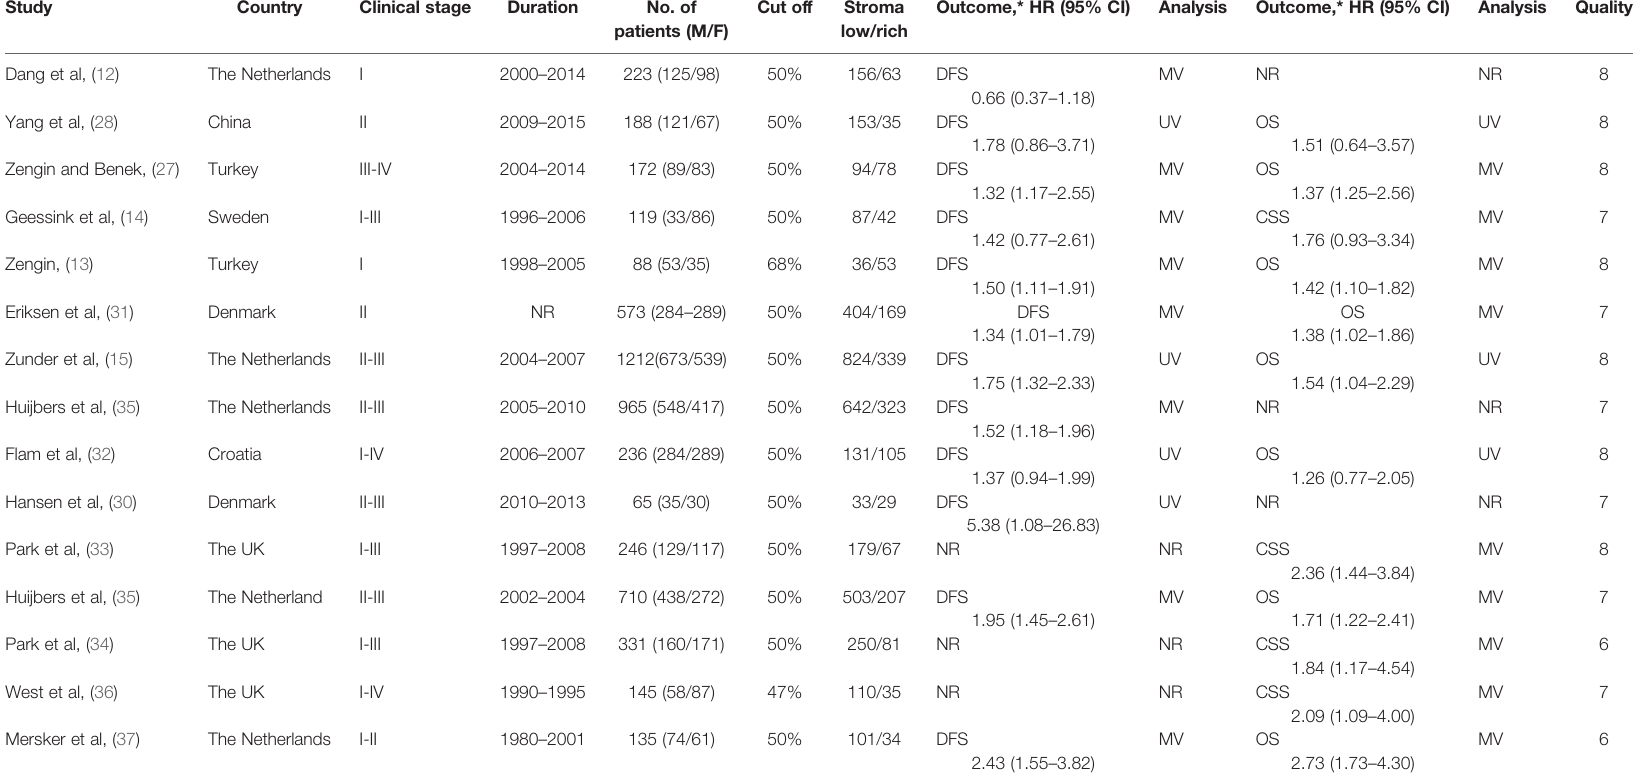
TABLE 2 | Characteristics of 15 studies included in the